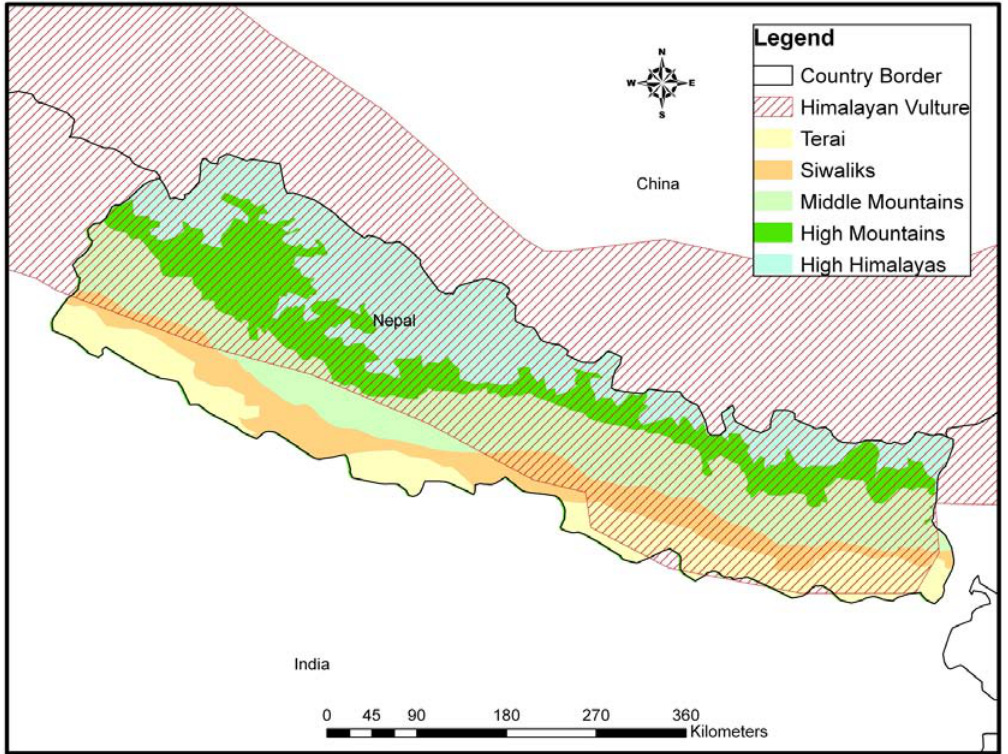
Figure 5. Himalayan Vulture distribution in Nepal. Adapted from (Birdlife International & NatureServe 2011).